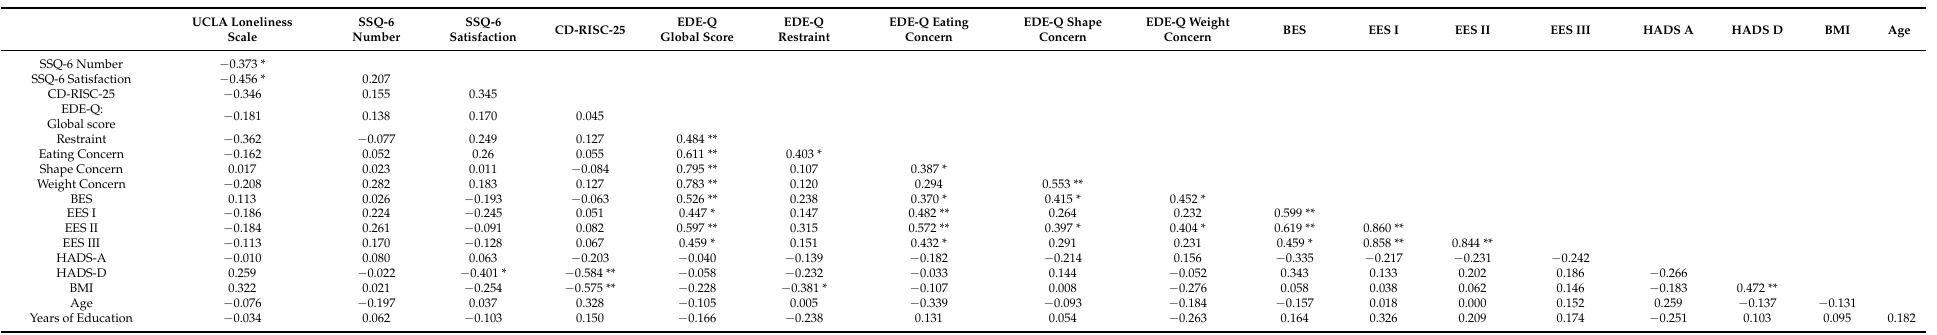
Table A3. Correlation matrix for the variables: loneliness, social support, eating disorder symptoms/features, resilience, binge eating, emotional eating, BMI, anxiety and depression levels, age, and years of education for the HC